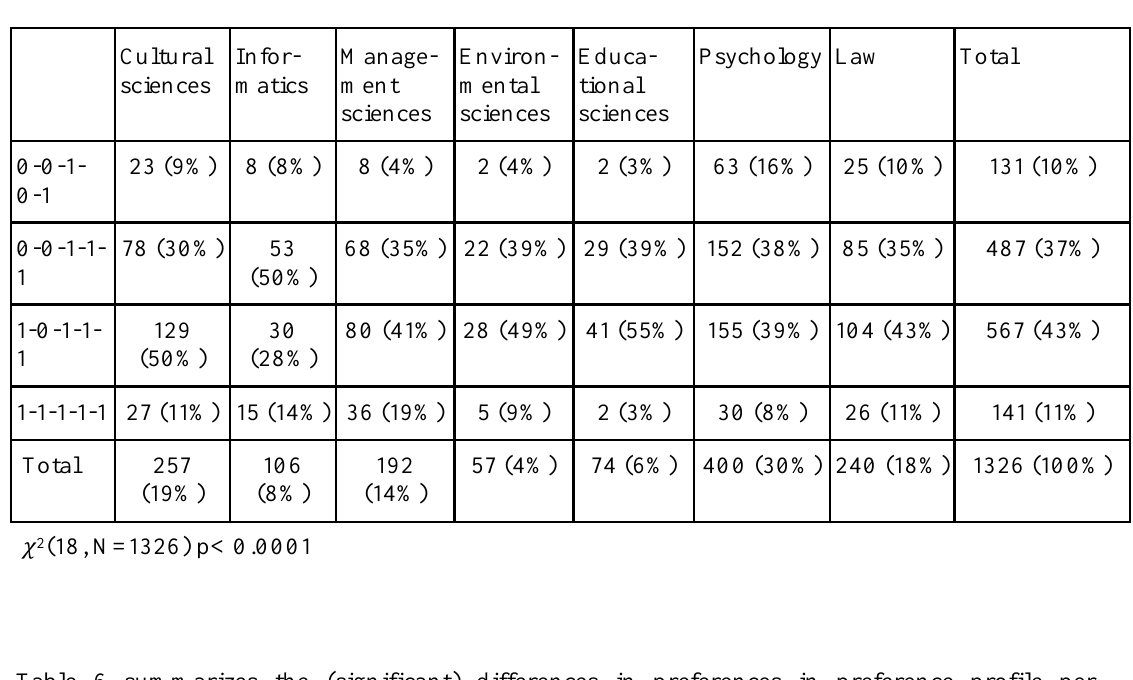
Top 4 Profiles and Differences per Discipline Among Enrolled